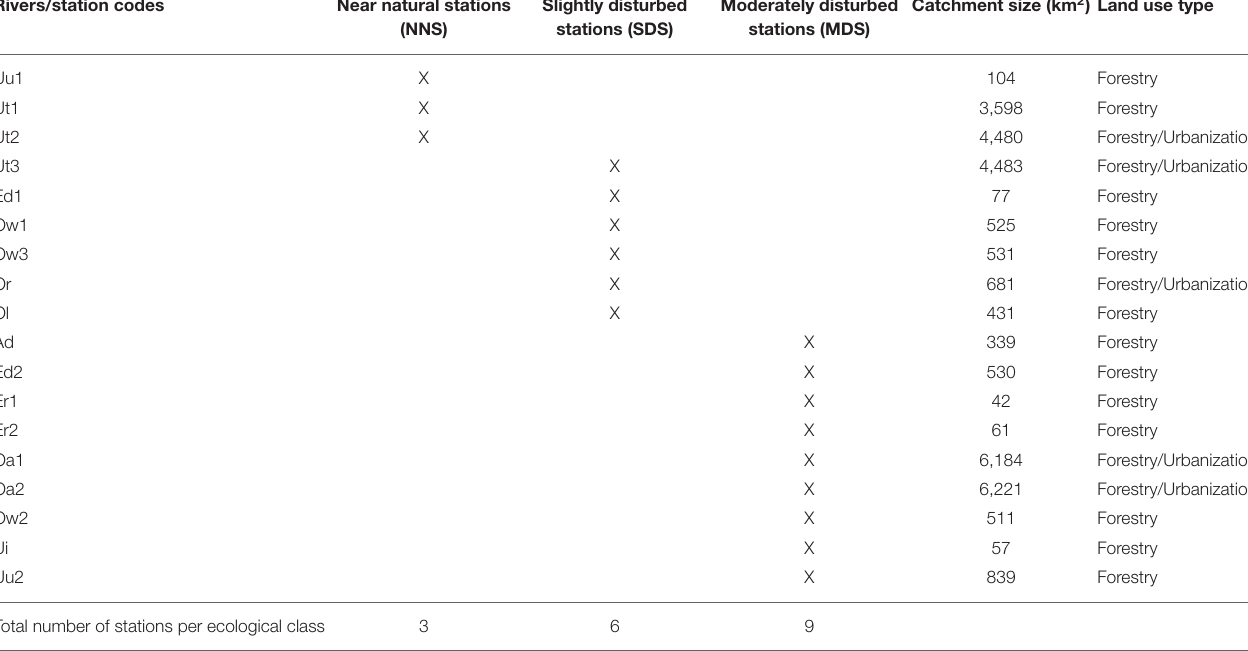
TABLE 1 | Stations ecological classification in the present study. Rivers/station